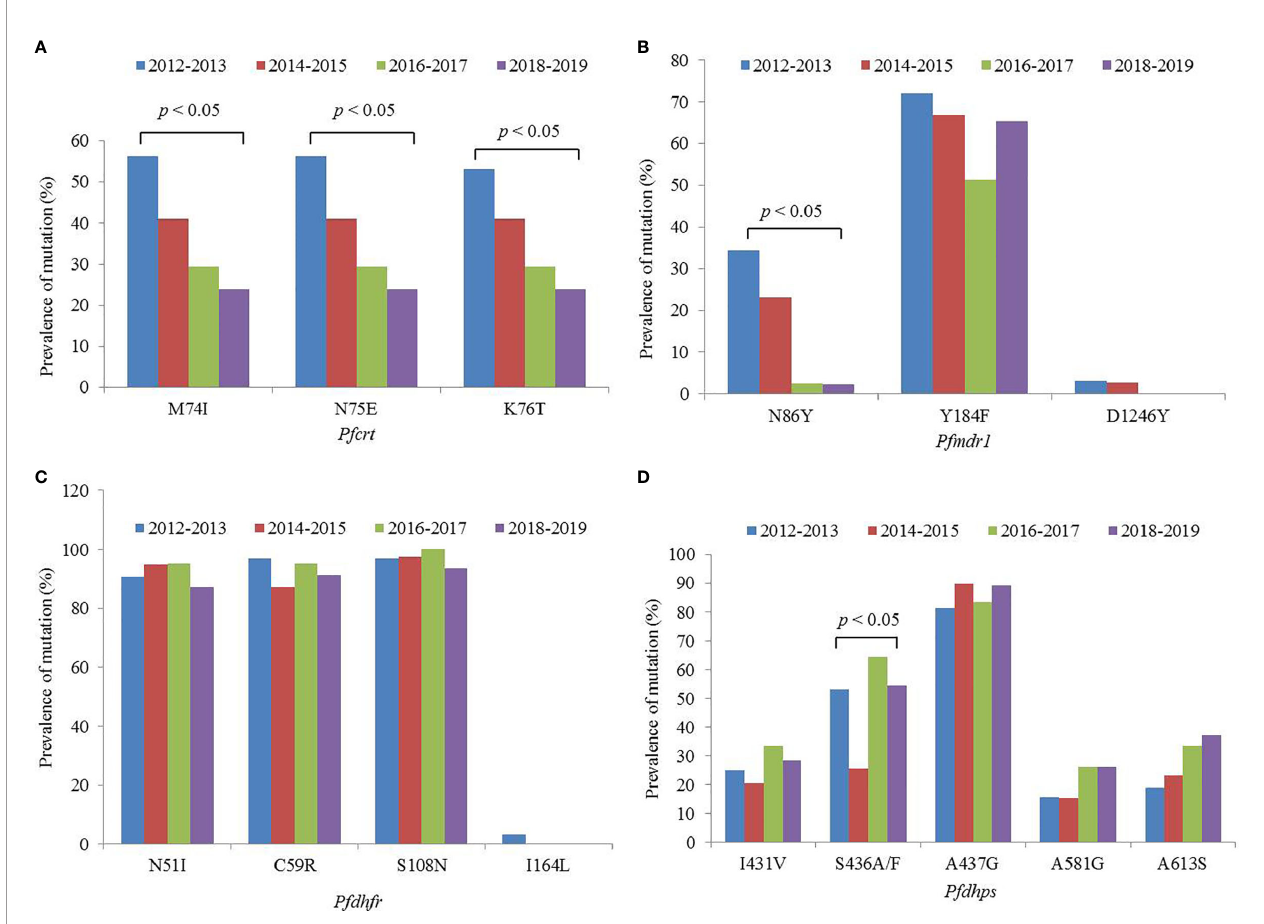
FIGURE 1 | Mutantprevalenceofthe (A) Pfcrt , (B) Pfmdr1 , (C) Pfdhfr , and (D) Pfdhps genesdetectedin Plasmodium falciparum isolates returnedfrom Nigeria,2012 –